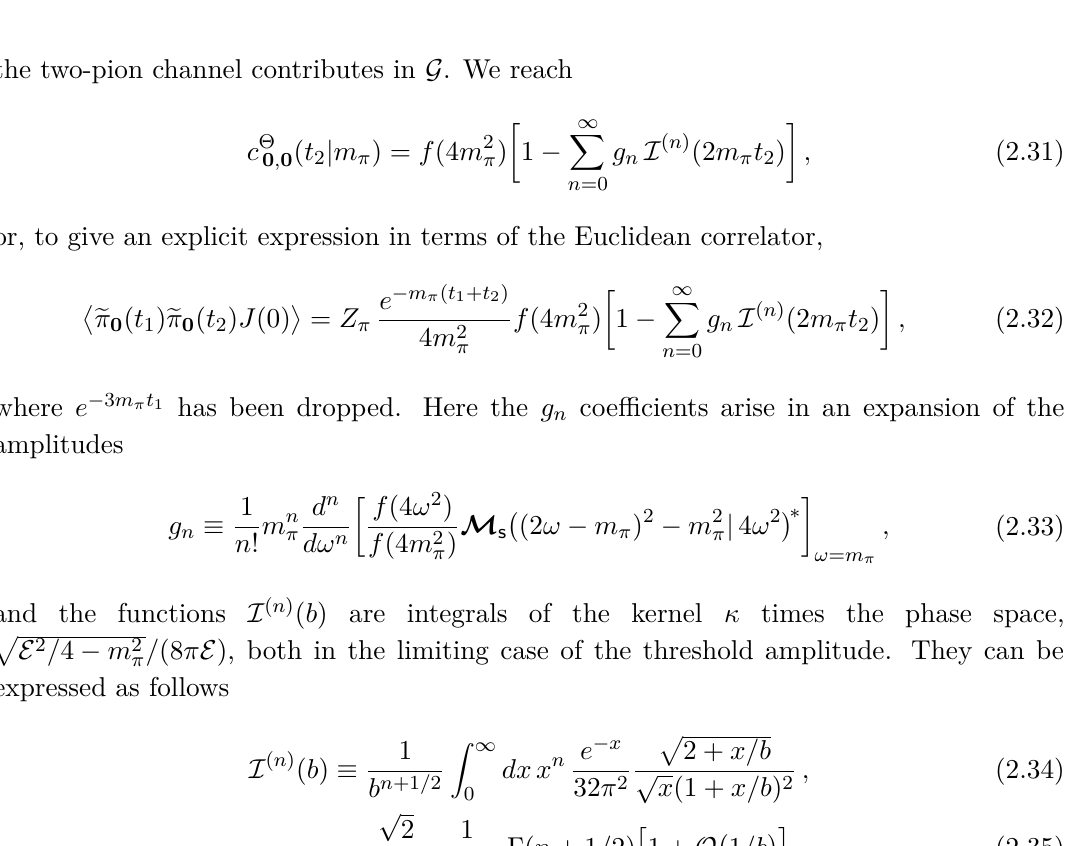
Figure 2 . Plot of the first few I ( n ) ( b ) functions (solid lines), defined in eq. (2.34) of the main text. The dashed lines show the large b expansion for each function, scaling as b − n − 1 / 2 as shown in eq. (2.35)